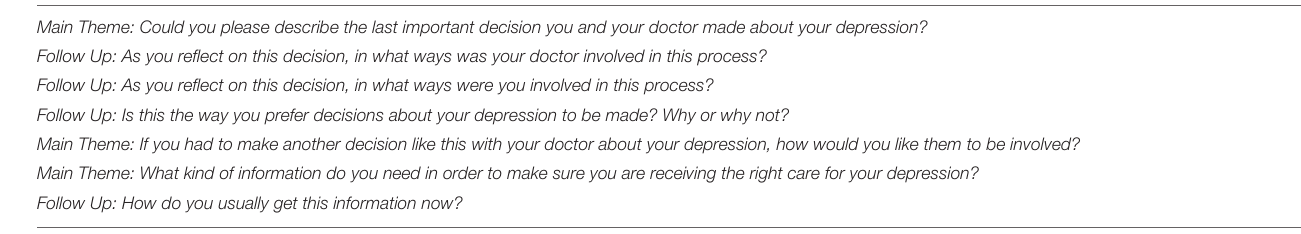
TABLE 1 | Sample interview